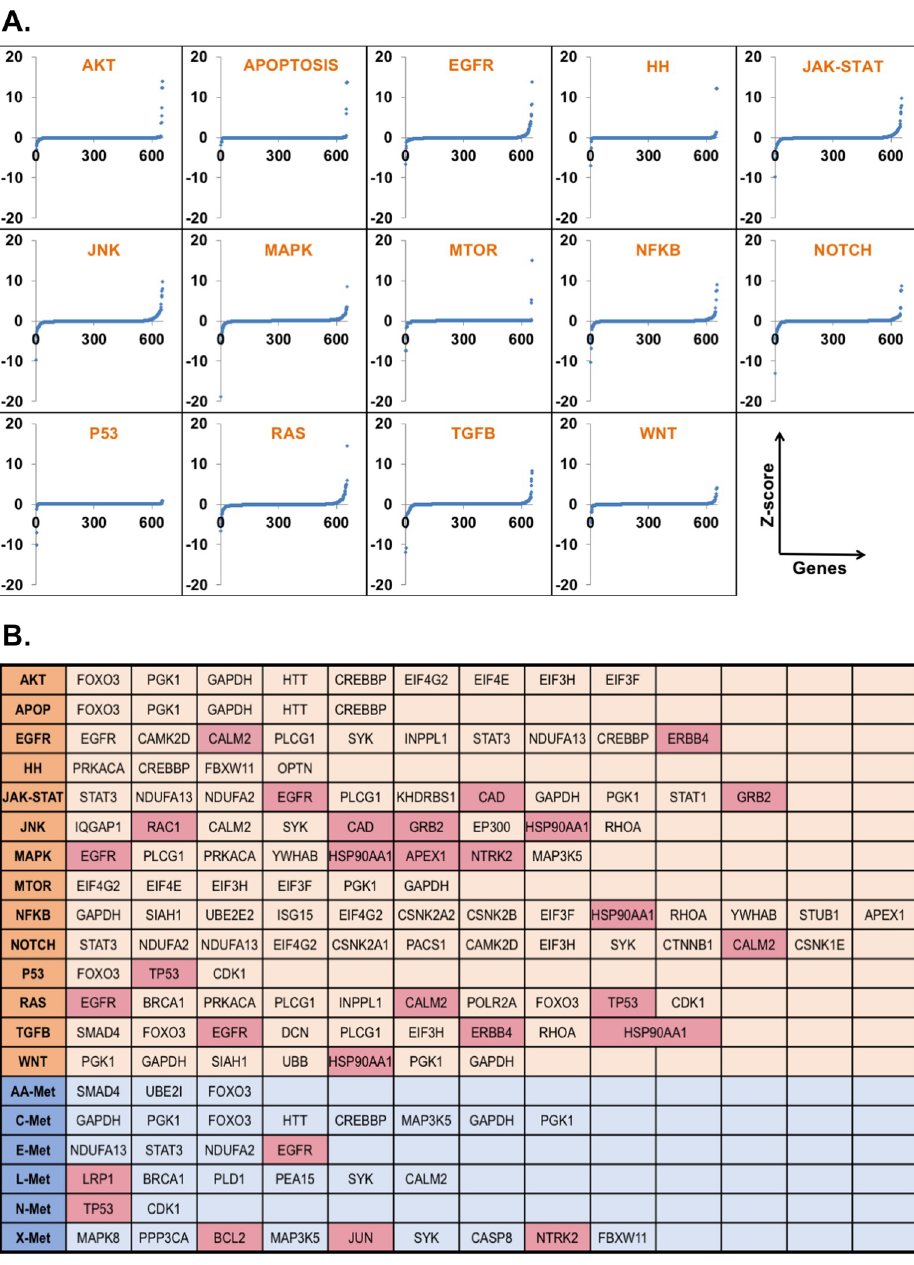
Fig 7. Importance of the individual nodes in signaling-metabolic pathway interconnection. (A) Each of the 654 nodes of the final network was tested in perturbation studies by removing it and its associated connections from the network and recalculating all network parameters. The scores for significant SM pairs (Z � 1) and interconnected paths (path score � 80% from the highest path score for each SM pair) were redefined for each signaling to all metabolic interconnections. The differences of the sums of all significant path scores before and after perturbation of the individual 654 nodes for each signaling to all metabolic pathway interconnections were converted to Z scores (blue dots) and plotted against the genes/nodes. (B) Summary of the nodes with a significant impact on the entire network. Nodes with significantly altered Z score after perturbation (-2 � Z � 2) were considered as effective nodes with significant impact and are listed in S3 Table for all interconnections of the 14 signaling pathways to the 6 metabolic pathway groups and vice versa , the metabolic pathway groups to the signaling pathways. Drugable node/proteins according to the KEGG database are